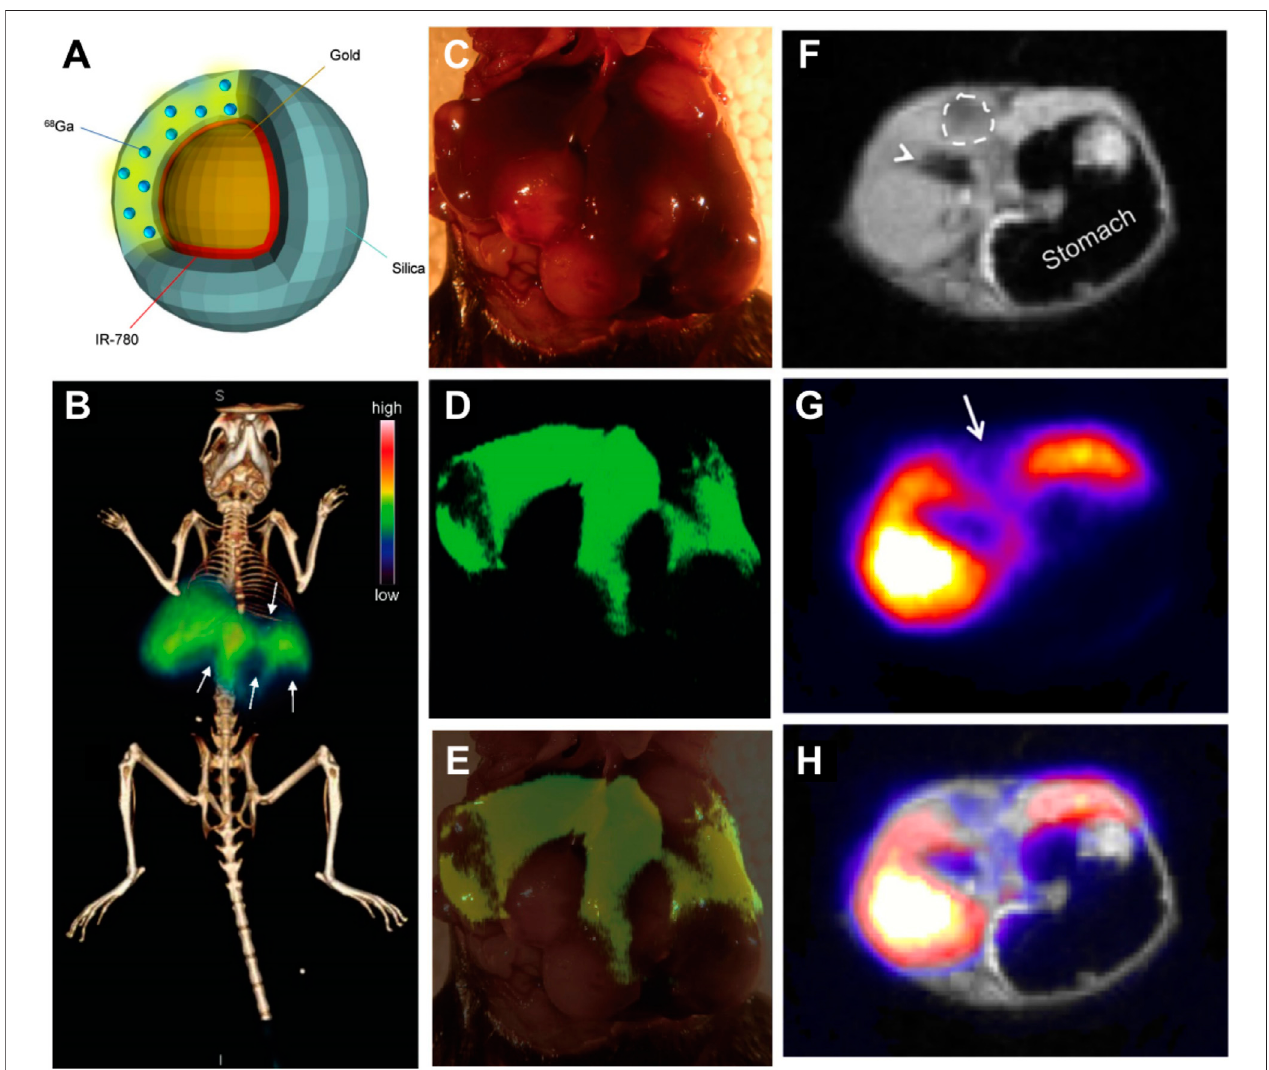
FIGURE 3 | (A) Schematic illustration of the PET-SERRS nanoparticle. (B) PET-computed tomography image of a tumor-bearing mouse after injection with PET- SERRSnanoparticles. (C) Theintraoperative whitelightimage oftheliver fromthemouse imaged in (A) . (D) SERRS imagingoftheliver (highSERRS signal)and location and extent of the tumors (signal voids) and (E) overlay of photograph and SERRS map. (F – H) PET-MRI of HCC using PET-SERRS nanoparticles. Reproduced with permission from Wall et al. (2017). Copyright (2017) Ivyspring International